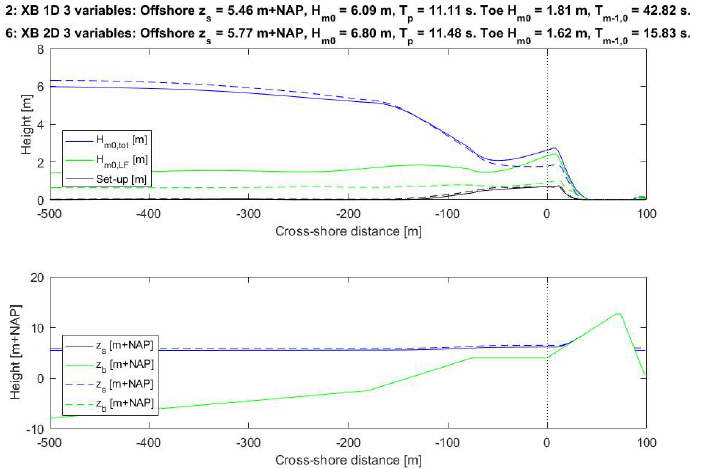
Figure 10. XBeach 1D (long-crested waves) with the three offshore conditions as stochastic variables (calc. 2) versus XBeach 2D (short-crested waves) with the three offshore conditions as stochastic (calc. 6) at the design point. The dike toe is indicated by the dotted line. The parameters offshore and at the toe of the dike are given in the title of the figure.